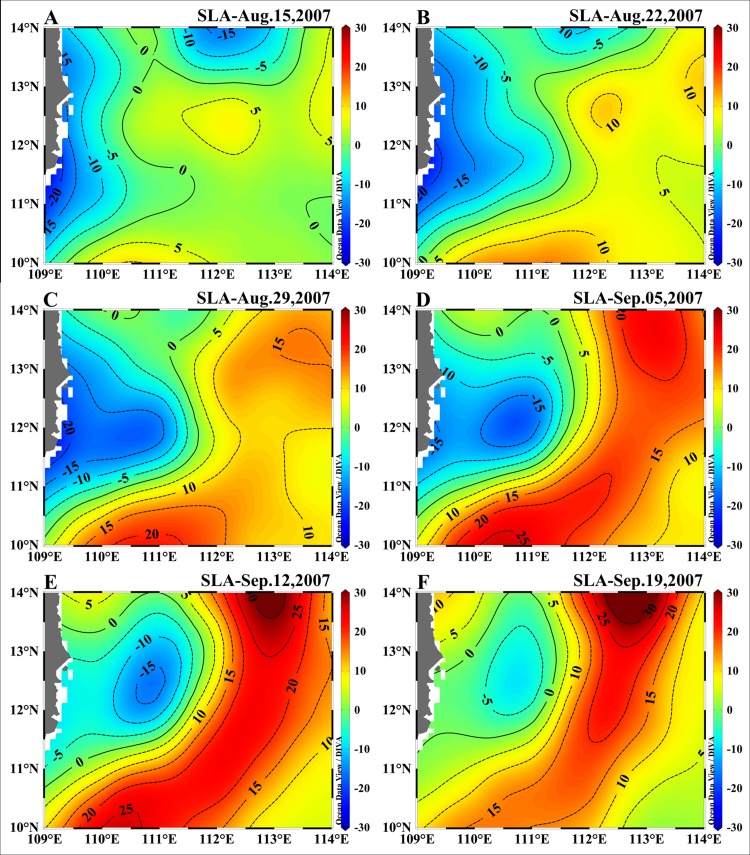
Evolution of the cyclonic eddy C2 in the western SCS during the cruise.The weekly merged data of the SLA product from the French AVISO data project, from 15 August to 19 September 2007.